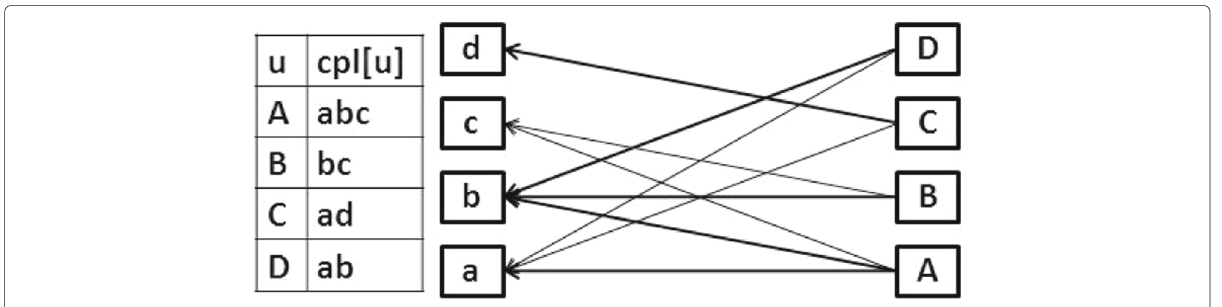
Fig. 12 After revoking read access of resource d from user B